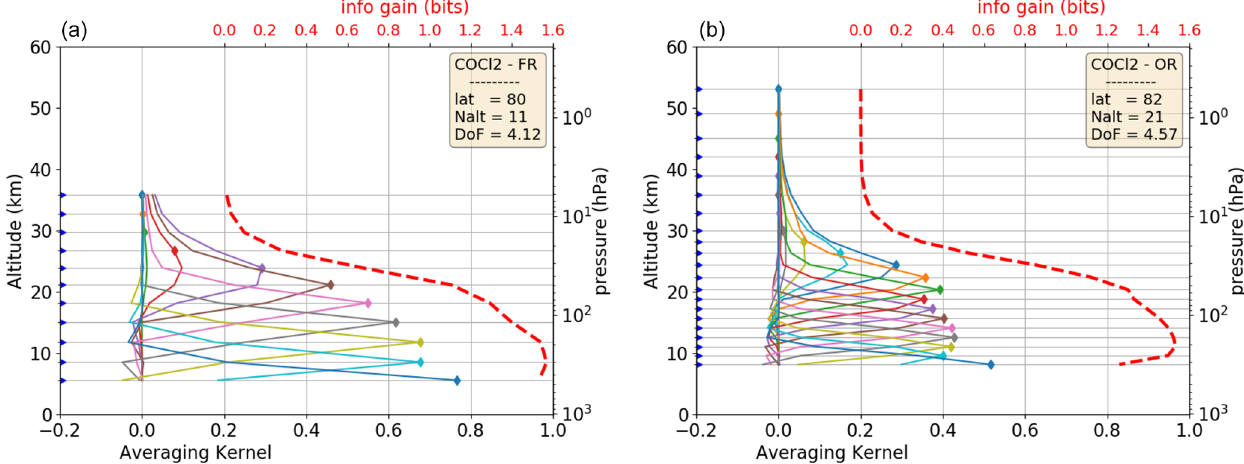
Figure 2. Typical AKs of individual COCl 2 profiles retrieved from FR (a) and OR (b) MIPAS measurements. The dashed red lines represent the information gain due to the